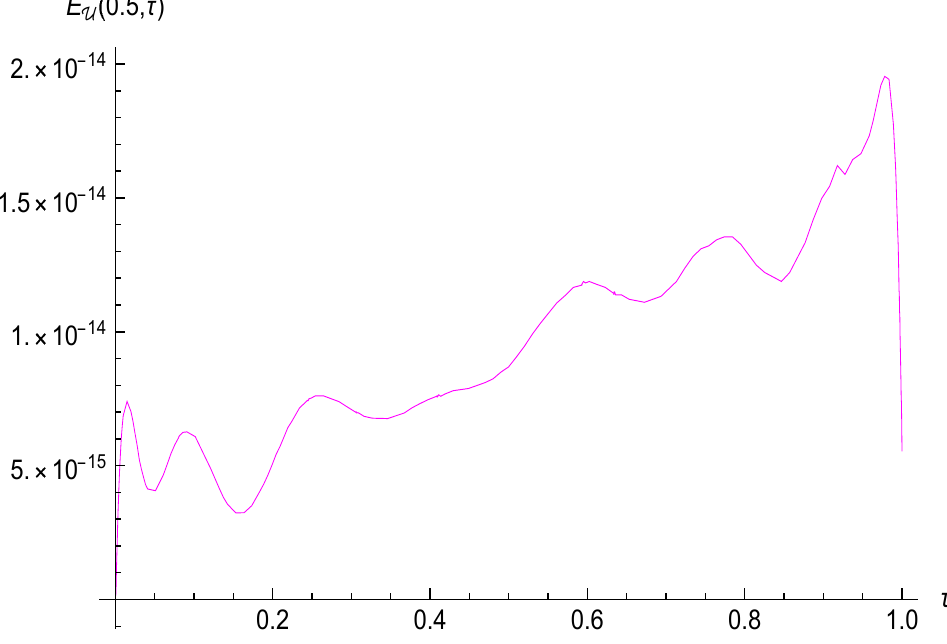
Figure 14. τ -Absolute errors E U ( 0.5, τ ) graph of the problem (33), where σ 1 = (cid:36) 1 = σ 2 = (cid:36) 2 = 0, ν = 0.9 and N = M =